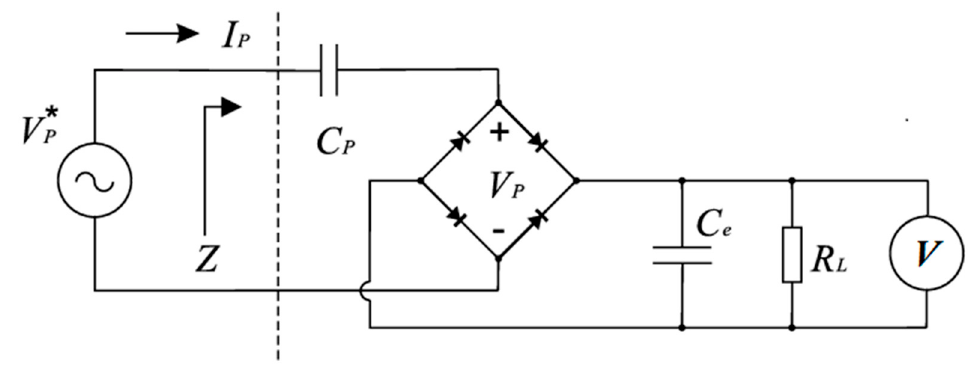
Figure 5. Energy harvesting circuit.